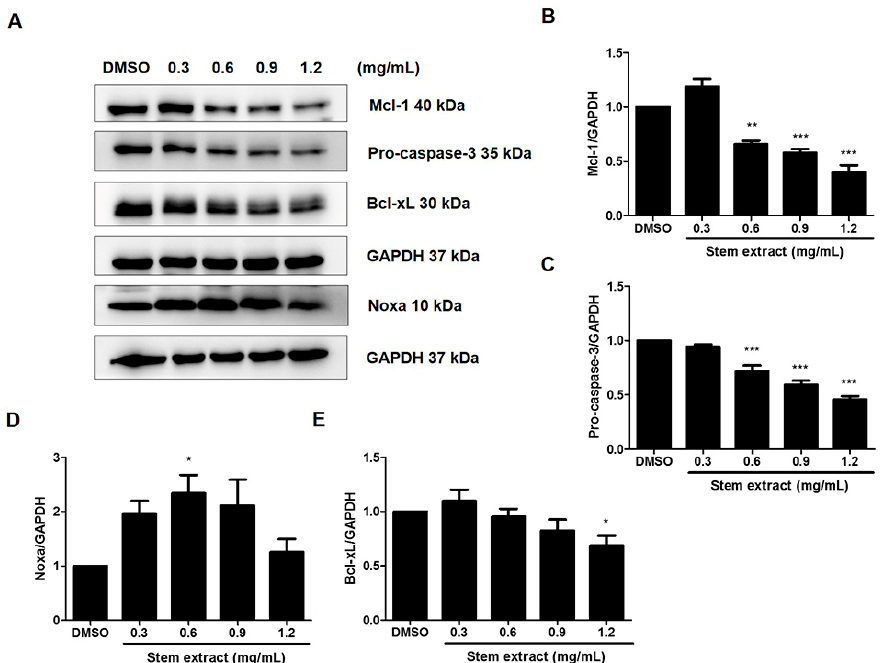
Figure 5. Effects of the stem extract on the expression of apoptosis-related proteins in PC-3 cells. Cells were treated with stem extract at 0, 0.3, 0.6, 0.9, and 1.2 mg/mL, and then Western blot analysis was performed with all samples. ( A ) Representative protein expression of McL-1, pro-caspase-3 Bcl-xL, and Noxa revealed by Western blot analysis. ( B – E ) The expression levels of each protein were quantified and normalized to GAPDH. The results are expressed as means ± SEM. * indicates p < 0.05, ** indicates p < 0.01, and *** indicates p < 0.001: a significant difference versus the control.